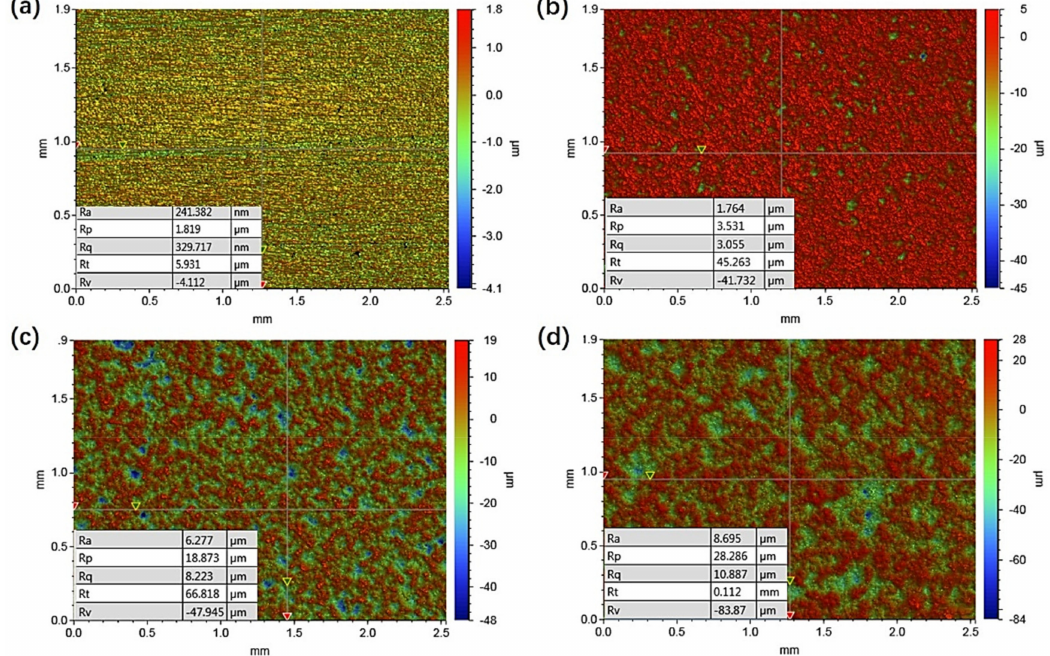
Figure 10. 3D surface morphology of the HT 800 coating: ( a ) before cavitation erosion; ( b ) after 2 h exposure; ( c ) after 4 h exposure; and ( d ) after 6 h